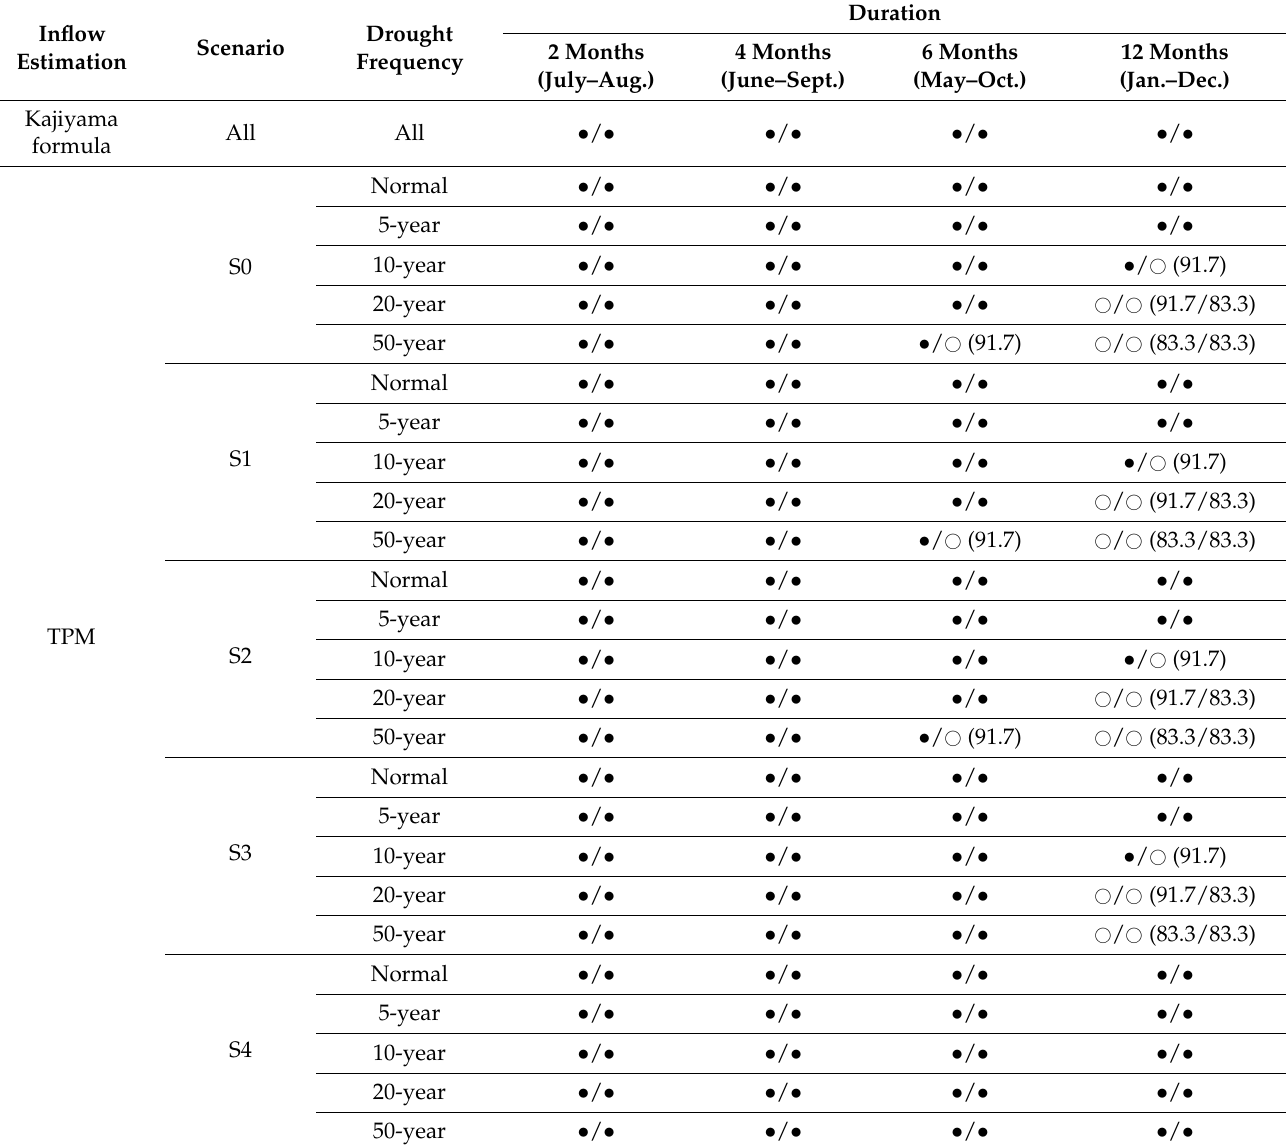
Table 5. Possibility and reliability of continuous water supply with conjunctive operation.